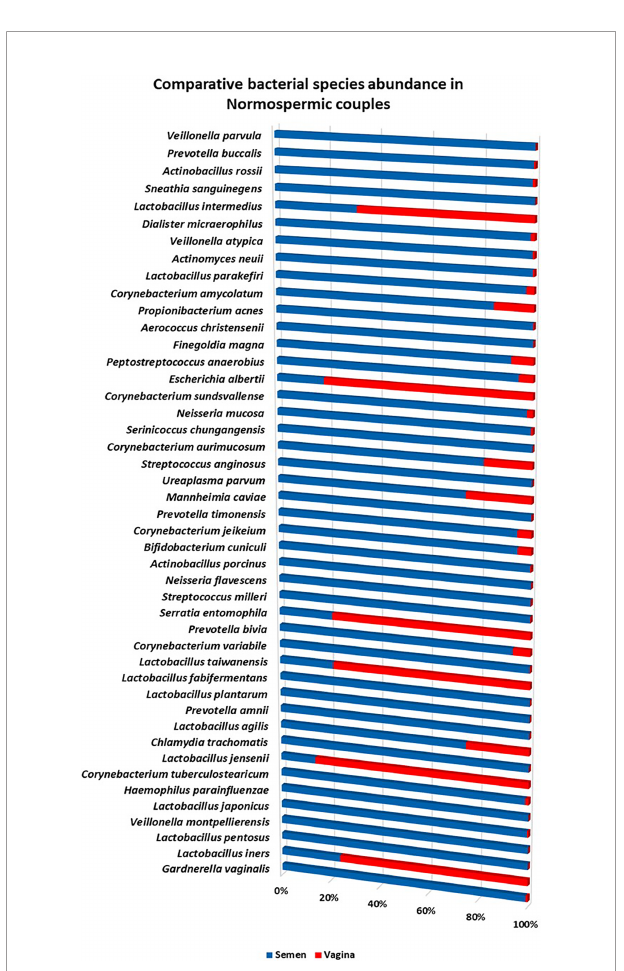
FIGURE 4 | Comparative relative (%) species abundance in normospermia